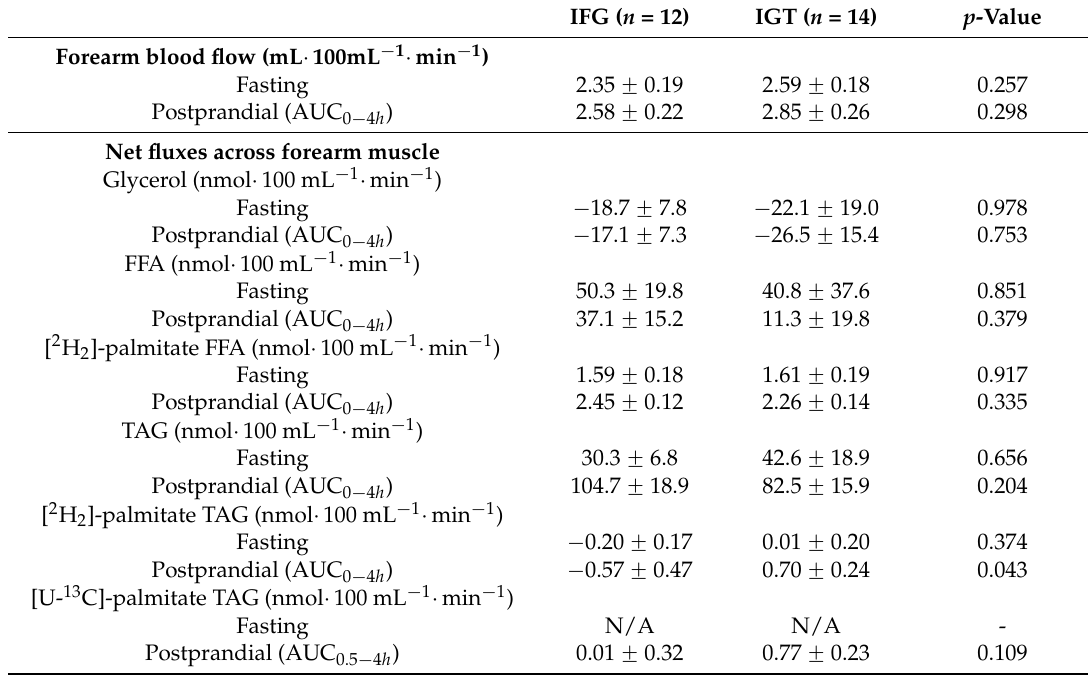
Figure 1. Fasting and postprandial glucose and insulin responses. ( A ) Arterialized plasma glucose concentrations; ( B ) Arterialized plasma insulin concentrations; ( C ) Net glucose uptake across forearm muscle during fasting ( t = 0) and after consumption of a high ‐ fat mixed ‐ meal in IFG (black circles, solid lines) and IGT subjects (open circles, dashed lines). Values are mean ± SEM. Table 3. Fasting and postprandial forearm blood flow and lipid metabolism. IFG ( n = 12)